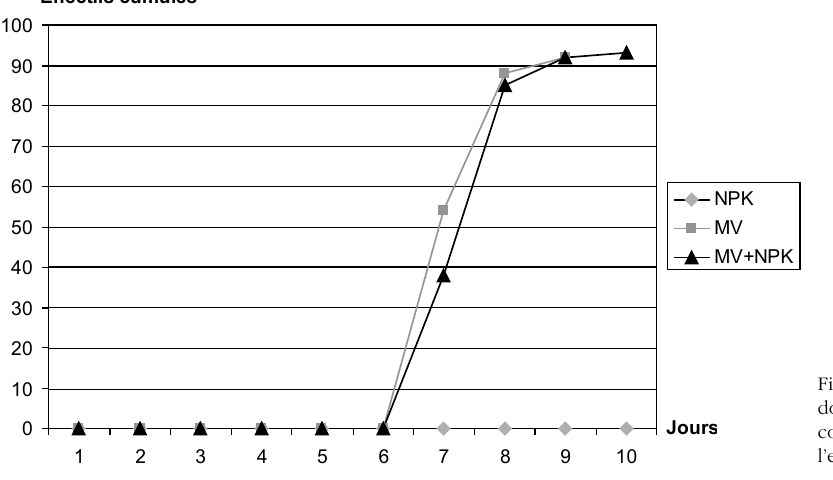
Fig. 1. – analyses physico-chimiques des eaux contenant de la matière végétale (mV), de l’engrais nPK et un mélange de mV+nPK (moyennes des teneurs en mg/l à partir des prélèvements faits à J nb : les dosages affichés pour chacun des paramètres analysés représentent la moyenne effectuée sur les cinq prélèvements.